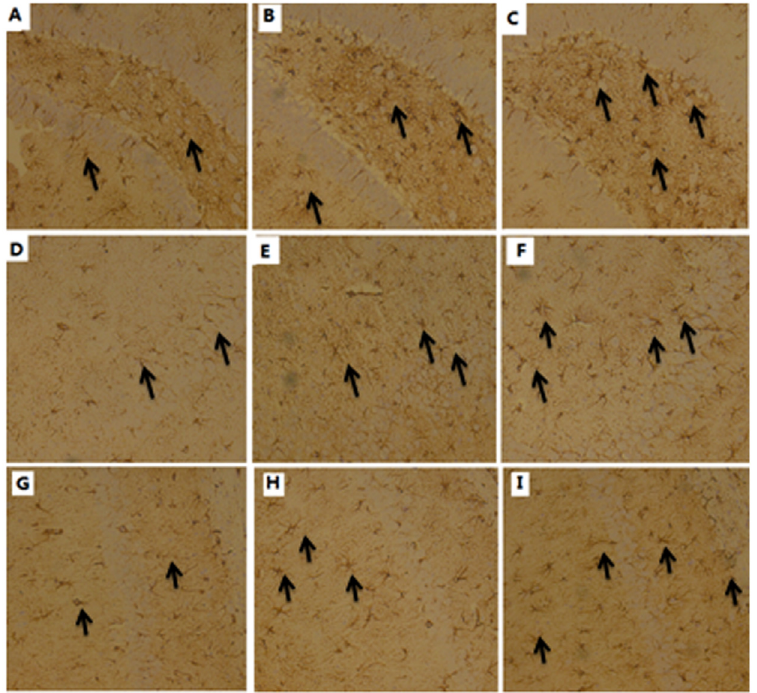
Fig 10. Representative immunohistochemical location of GFAP in DG (A-C), CA3 (D-F) and CA1 regions (G-I) of the hippocampus (200×). The sections from control group (A, D and G), TDBP-TAZTO 5 mg/kg group (B, E and H) and 50 mg/kg group (C, F and I). The arrows indicates astrocytes. DG, CA3 and CA1 areas had some small dispersed non-branched astrocytes in the control rats (A, D and G, respectively), while small or large branched astrocytes in 5 mg/kg (B, E and H, respectively) and 50 mg/kg rats (C, F and I, respectively).